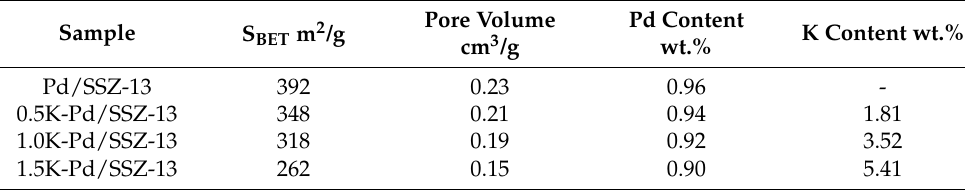
Table 1. Physicochemical property of Pd/SSZ-13 and K-deactivated samples. Sample